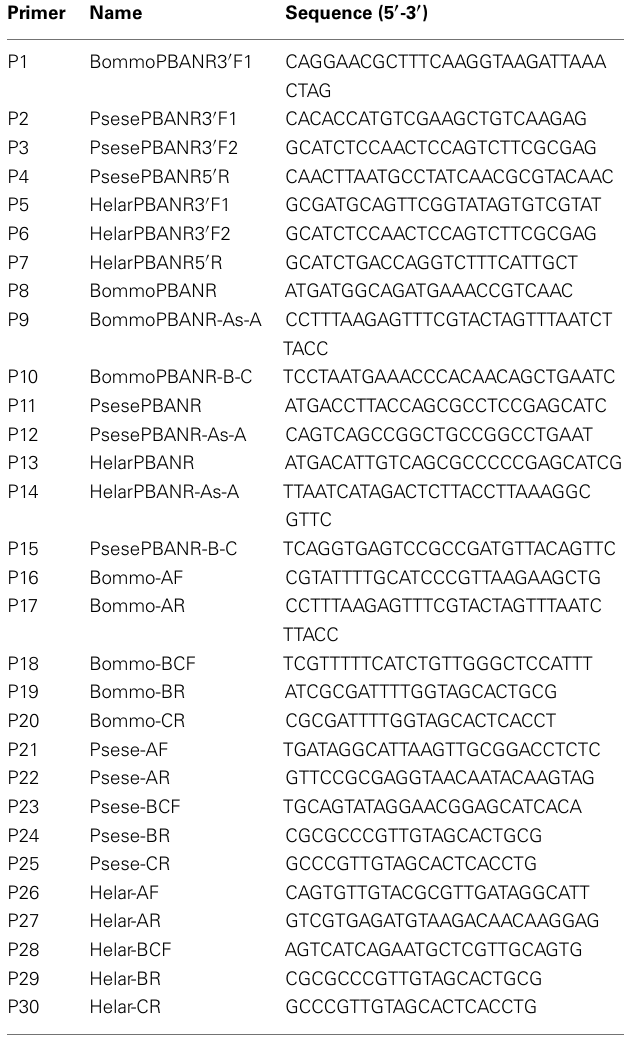
Table 1 | Species-specific PCR primers used to amplify the PBANR